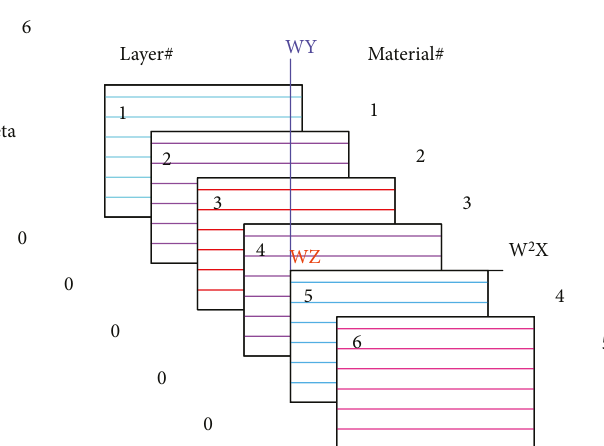
Figure 8: Layer parameters of fl exible composite shell.